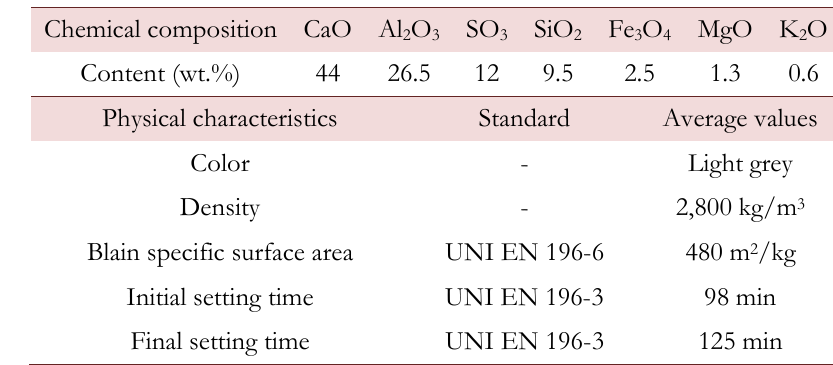
Table 1: Chemical and physical properties of cement [27]